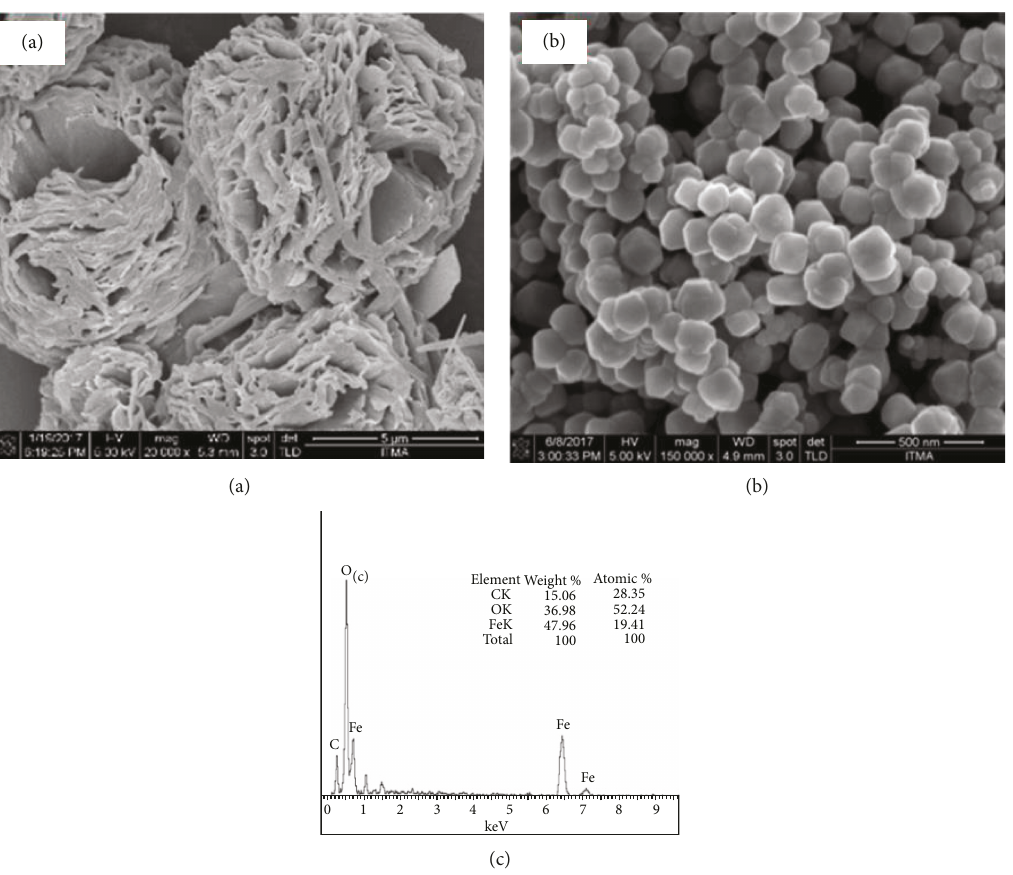
Figure 3: SEM images of poly(4,4 ′ -cyclohexylidene bisphenol oxalate) (a) and poly(4,4 ′ -cyclohexylidene bisphenol oxalate)-MCC-Fe composite (b). The EDAX analysis of the fi nal composite is shown in (c).